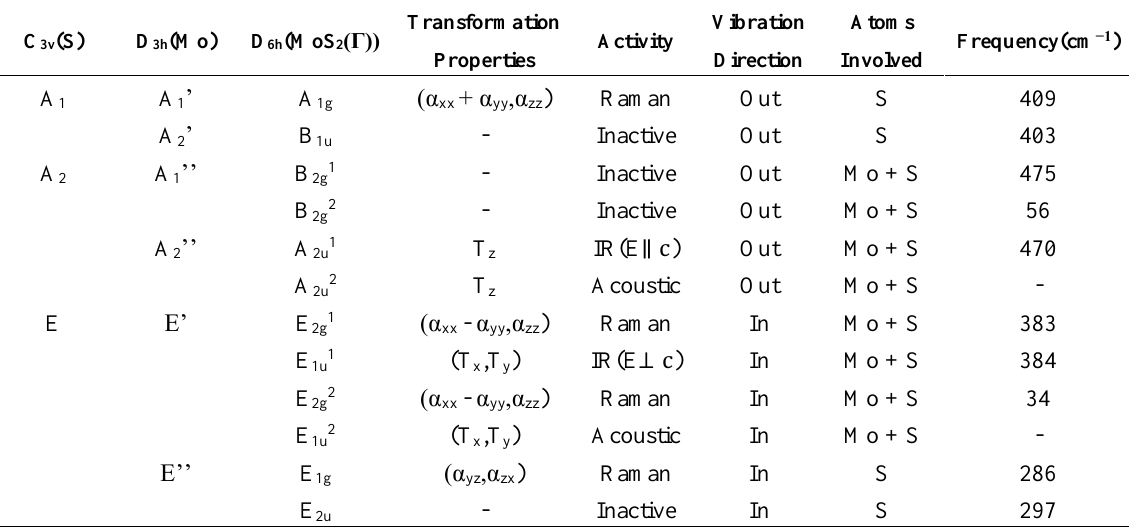
Table 2 ． Relevant phonon irreducible symmetry representations of S atoms (C 3v ), Mo atoms (D 3h ), and bulk 2H-MoS 2 point group D 6h . This table is compiled from the work of T. J. Weiting et al. [80], A.M. Sanchez et al. [38], and T. Livneh et al. [84]. Some vibration frequency data were measured by